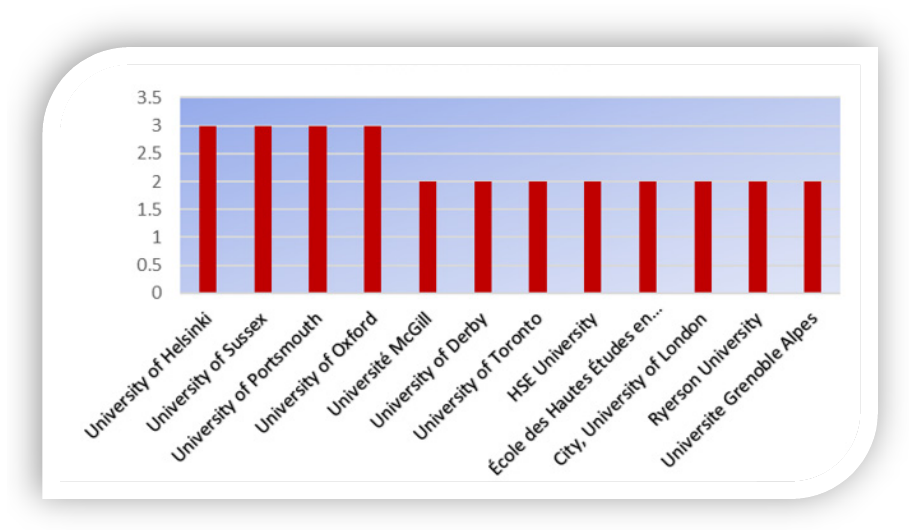
Figure 7. Organizational Affiliations of the Authors.